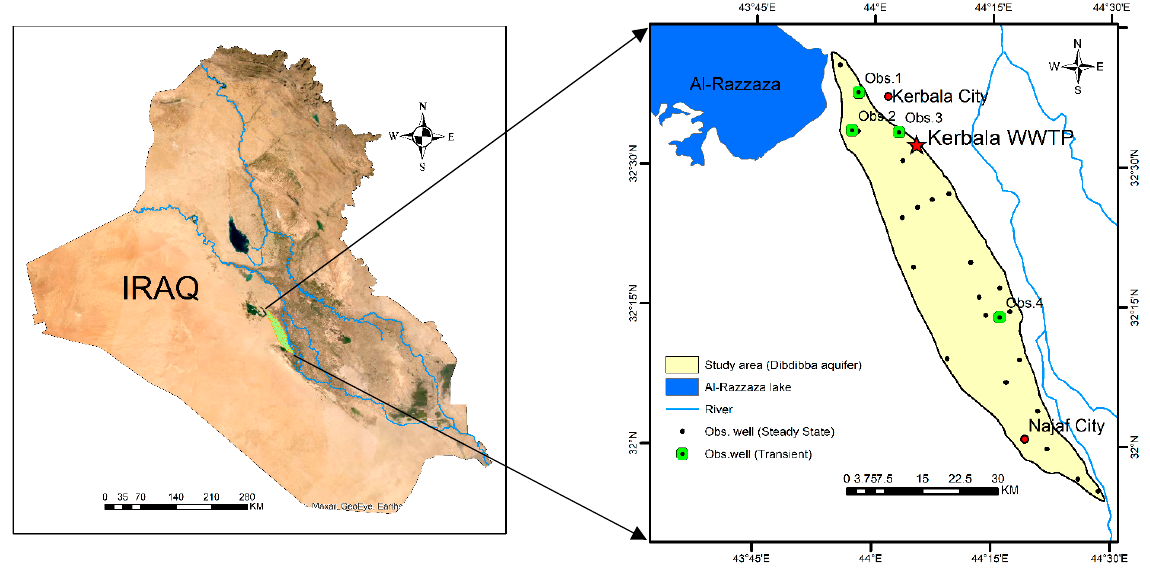
Figure 1. The study location with the Karbala